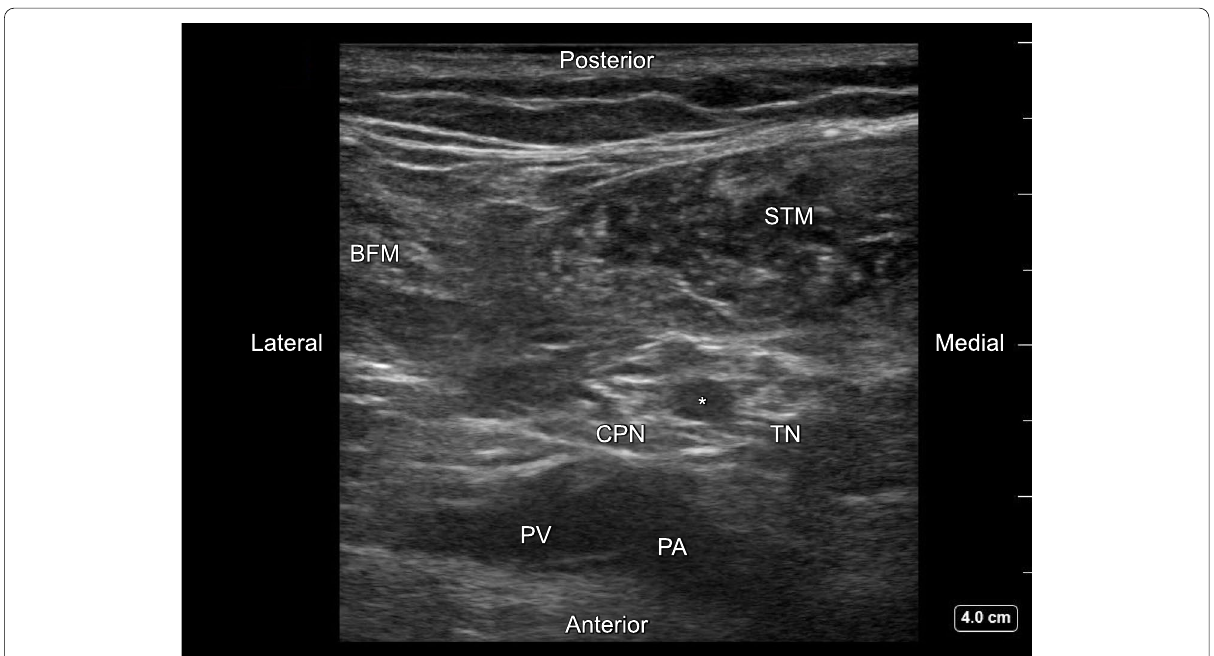
Fig. 1 Ultrasound image of an artery within the paraneural sheath between the tibial nerve (TN) and the common peroneal nerve (CPN) at slightly peripheral to the bifurcation of the sciatic nerve. A round hypoechoic pulsating structure (asterisk) was identified between two honeycomb structures (TN and CPN). The diameters of the artery between TN and CPN (asterisk) and the popliteal artery that were measured by the caliper function of the ultrasound machine were 3.2 4.2 mm and 5.0 6.1 mm, respectively. TN, tibial nerve; CPN, common peroneal nerve; BFM, biceps × × femoris muscle; STM, semitendinosus muscle; PA, popliteal artery; PV, popliteal